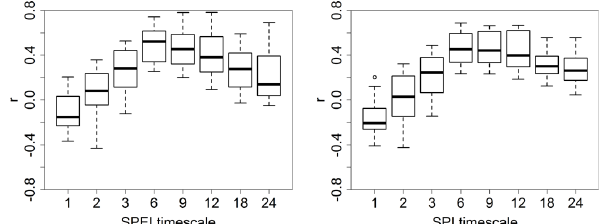
Fig. 5. Box plot for the correlation of NDVI and multiple timescales of SPEI and SPI; r is the correlation coefficient. The figure is based on the months January to May, and the land uses cereals, cropland, mosaic and shrubland. Hence, altogether there are 20 values for each timescale.